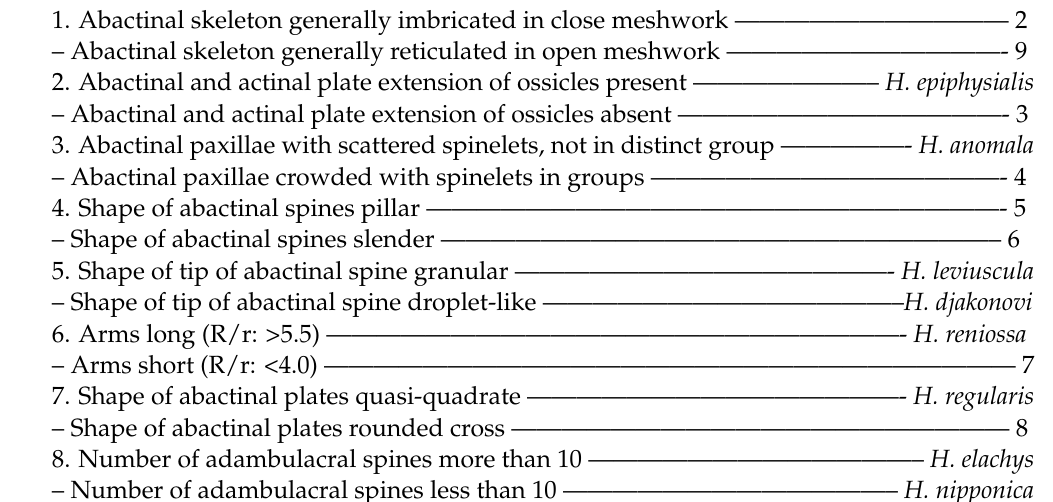
Figure 3. The maximum likelihood tree of 10 species of Henricia based on the cytochrome c oxidase subunit I (COI) dataset (420 bp). Henricia djakonovi in this study is marked with red letters. Bootstrap values are indicated on each node. Table 2. Pairwise genetic distances (%) within 12 asteroids, comprising 10 species of Henricia and two species of Luidia , from South Korea and GenBank, based on the Kimura 2-parameter model.